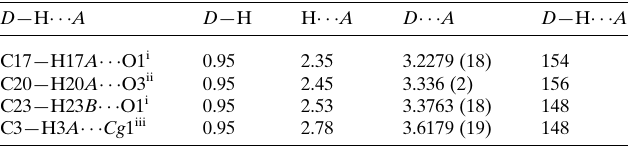
hydrogen bonds (Table 2) link the molecules into infinite chains along the c -axis direction (Fig. 3).